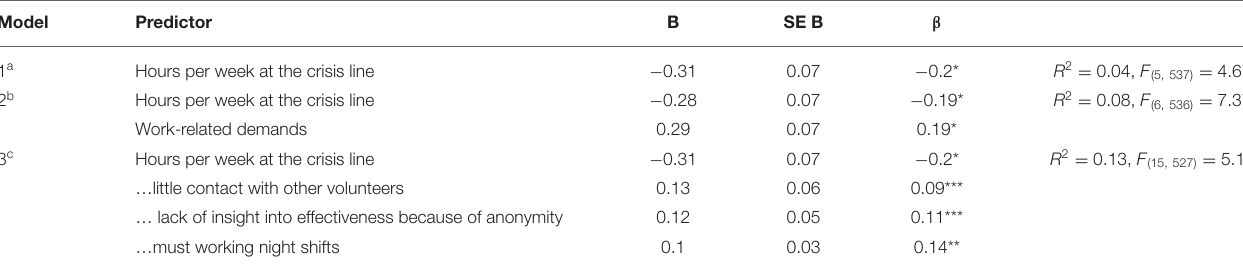
TABLE 6 | Summary of multiple regression analysis of determinants of intention to leave ( N = 543).